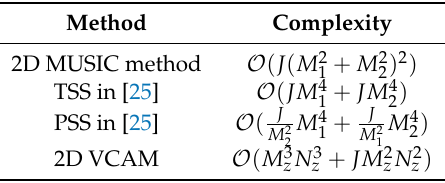
Table 1. Computational complexity